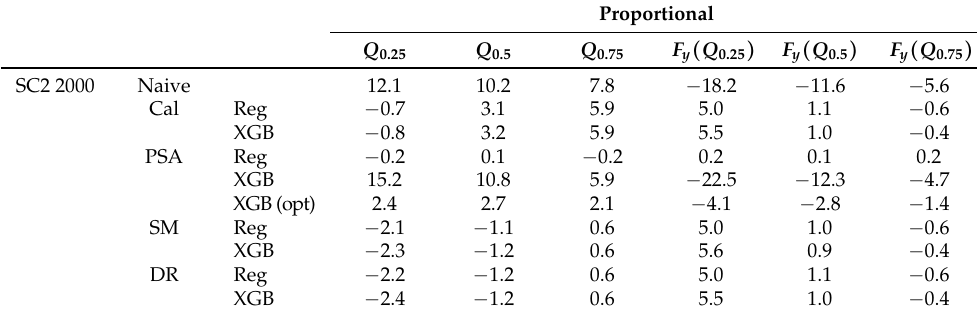
Table 3. Bias (%) including hyperparameter optimization when overfitting.